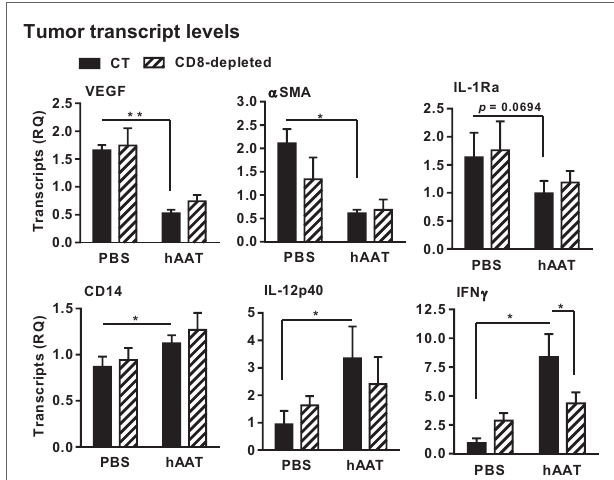
FigUre 5 | In vivo haaT treatment induces pro-inflammatory gene expression profile in rMa tumor mass . PBS- and hAAT-treated RMA tumor-bearing mice ( n = 3 per group) were sacrificed 17 days after RMA cell inoculation (1 × 10 5 cells per animal, s.c.). Tumors were excised and processed for real-time QPCR gene expression analysis for indicated genes.